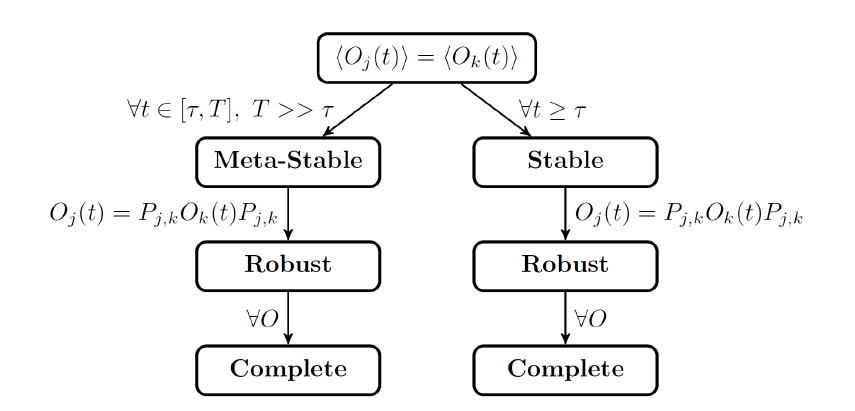
Figure 2: Visualization of the different definitions of synchronization. If we have equality in the expectation value of some non-stationary observable on different sites for some initial state, then we classify the signals as either stably or metastably syn- chronized. If, in fact, we have equality on the operator level, then they are robustly synchronized. Finally, if this holds for all non-stationary operators, then we say the subsystems are completely